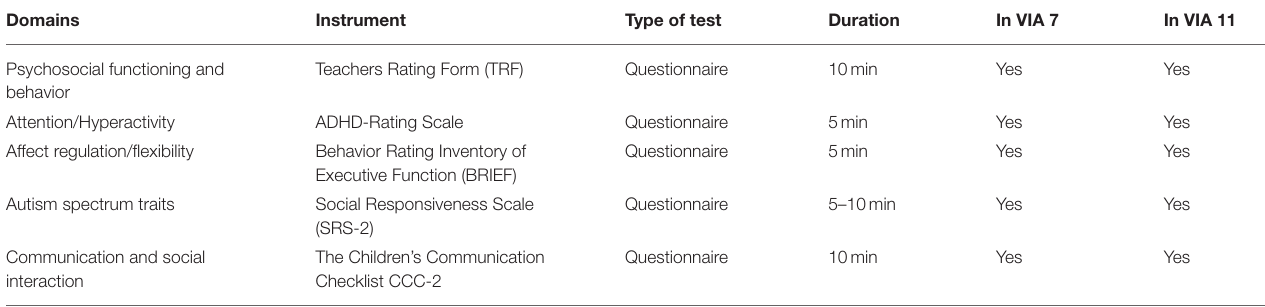
TABLE 3 | Assessment battery for the adolescents’ teachers in The Danish High Risk and Resilience Study VIA